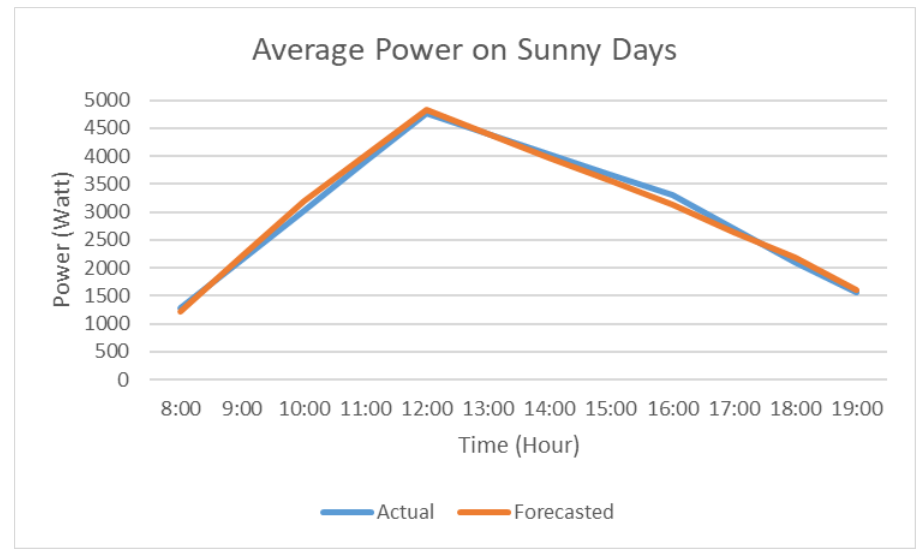
Figure 7. Actual versus forecasted curve of average solar power for the WT-ANFIS-HFPSO on sunny days.